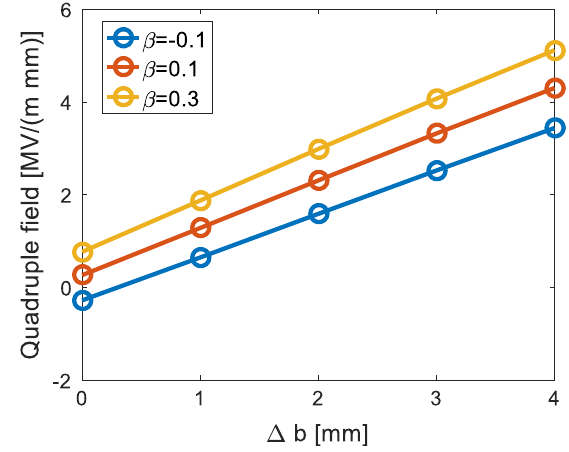
FIG. 21. Amplitude of quadruple components versus wall geometry.